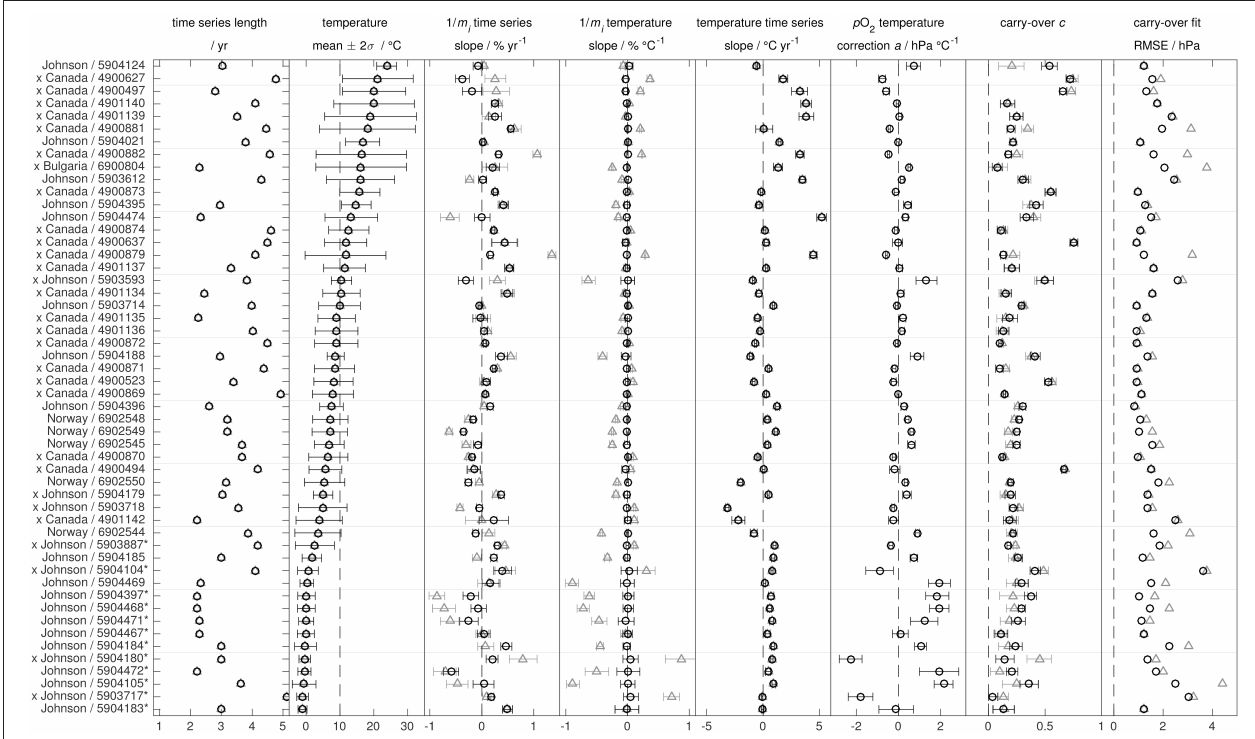
FIGURE 9 | Results of the in air analysis according to Equation (21) (gray triangles; without p O 2 - T slope a ) and (23) (black circles; with p O 2 - T slope a ) for optodes with factory batch calibration. Error bars give the 95 % confidence interval. Floats with Aanderaa 3830 optodes are marked with an x whereas all other floats carry an Aanderaa 4330 optode. Floats intermittently operating under sea ice are denoted by an asterisk.